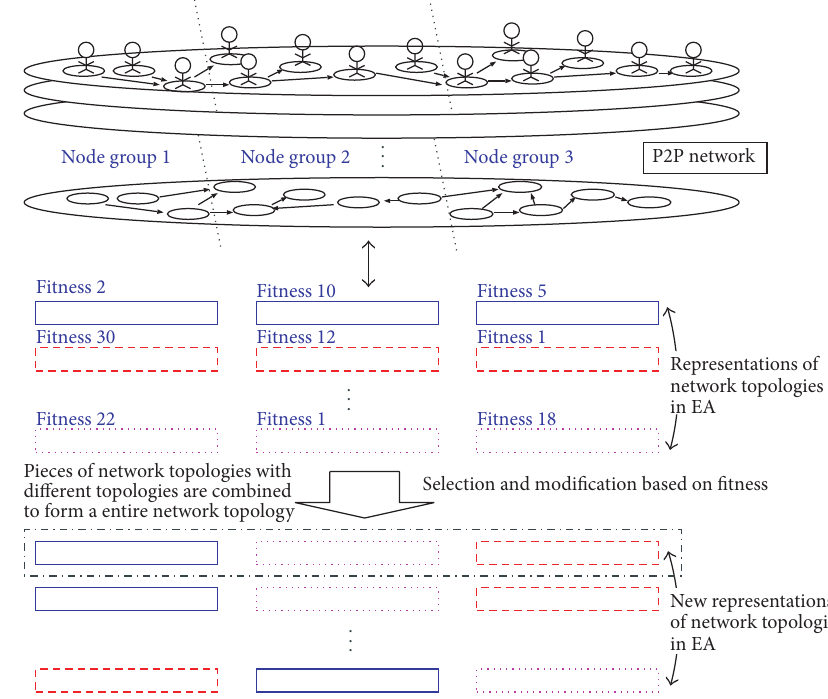
Figure 6: Problem of the parallel evolutionary P2P networking